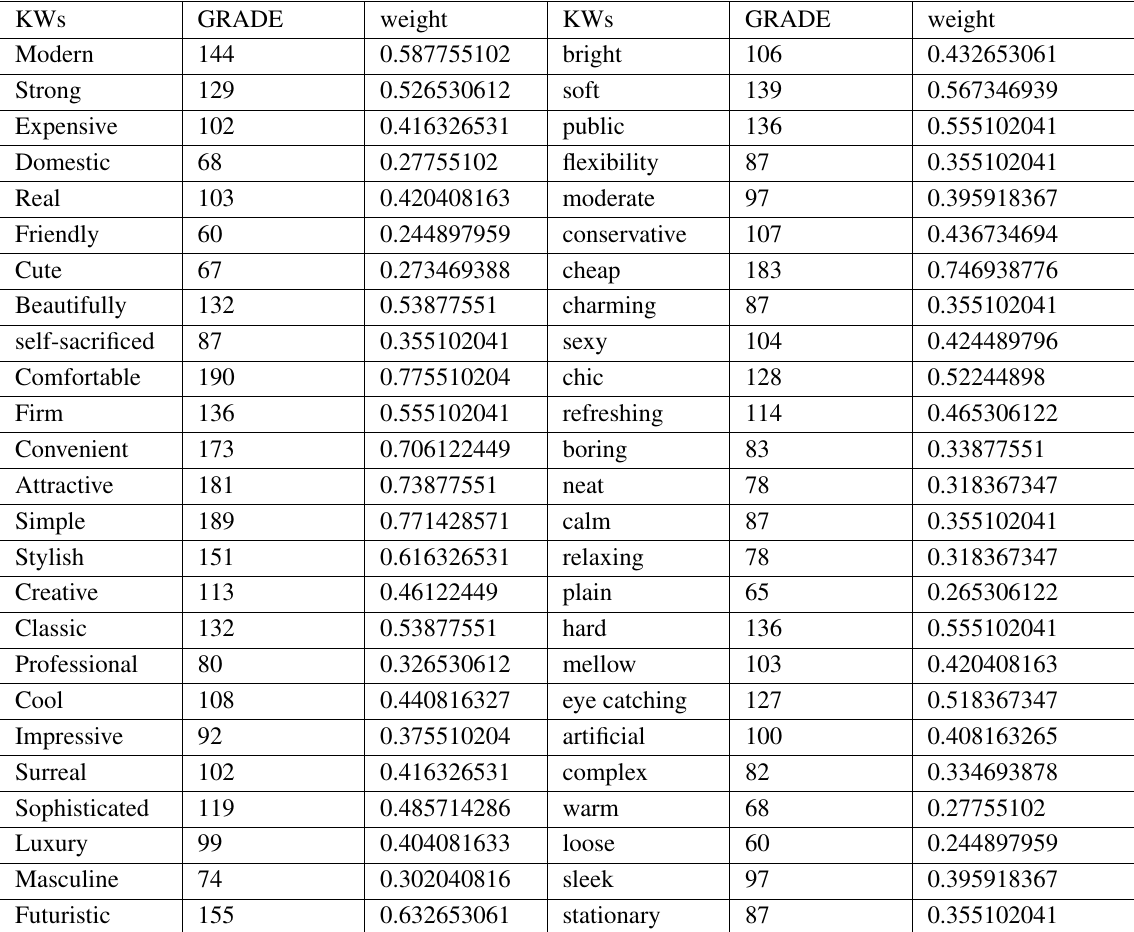
Table 3. Grade and weighting of Kansei